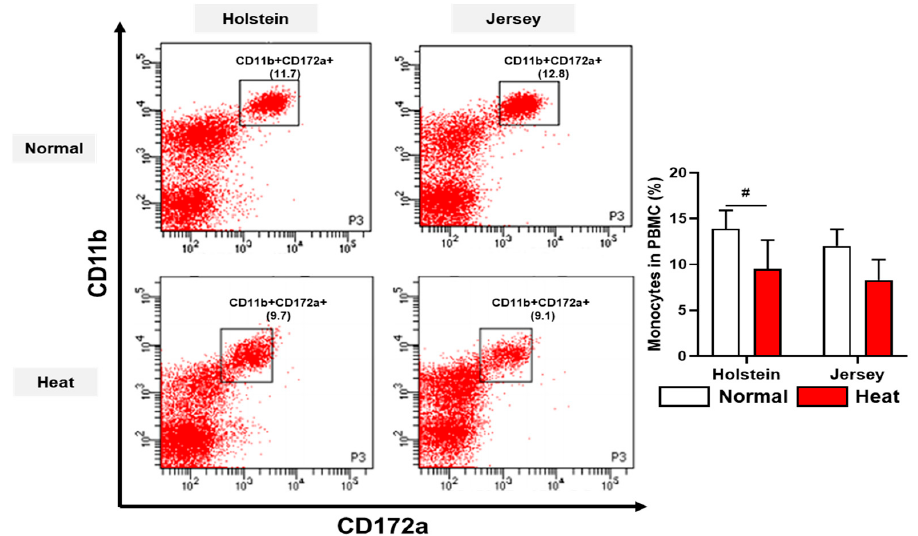
Figure 7. Alteration in blood monocytes in PBMCs from two breeds of dairy cow under different environmental conditions. The populations of monocytes (CD11b+CD172a+) in Holstein and Jersey cows under normal and high-heat environmental conditions were analyzed using flow cytometry. Data are represented as means ± standard deviation (SD); n = 7–8 animals/group. Values were statistically analyzed by a mixed-effects model with Tukey’s multiple comparison test. # p <